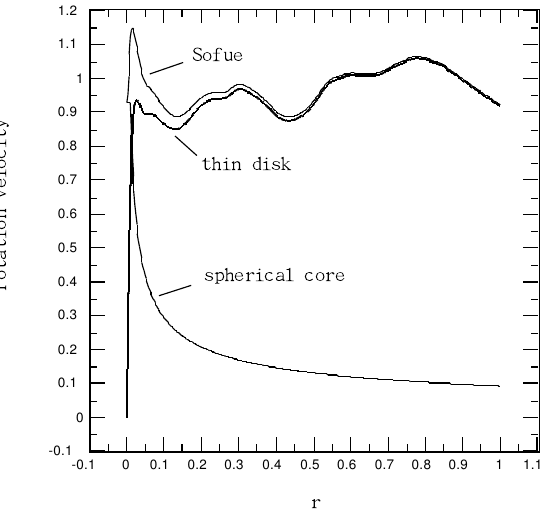
Figure 6. Profiles of the Milky Way rotation curves when decomposed into that = 0 . 01 and a thin disk. The original rotation curve corresponding to a spherical core of R c from Sofue is also shown here as a